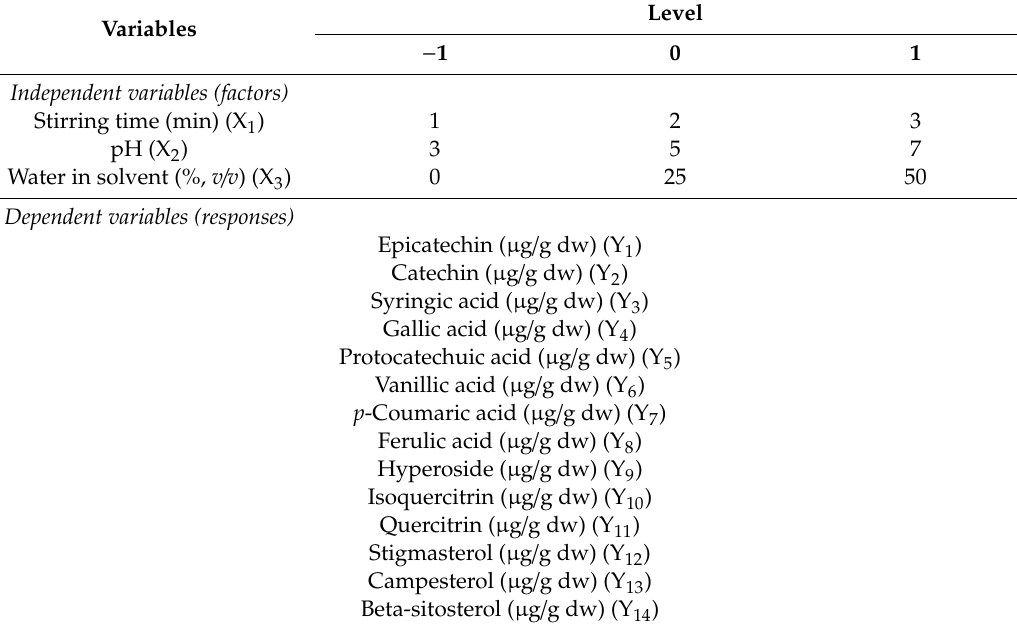
Table 2. Independent and dependent variable of experimental design used in the optimization step. Level Variables − 1 0 1 Independent variables